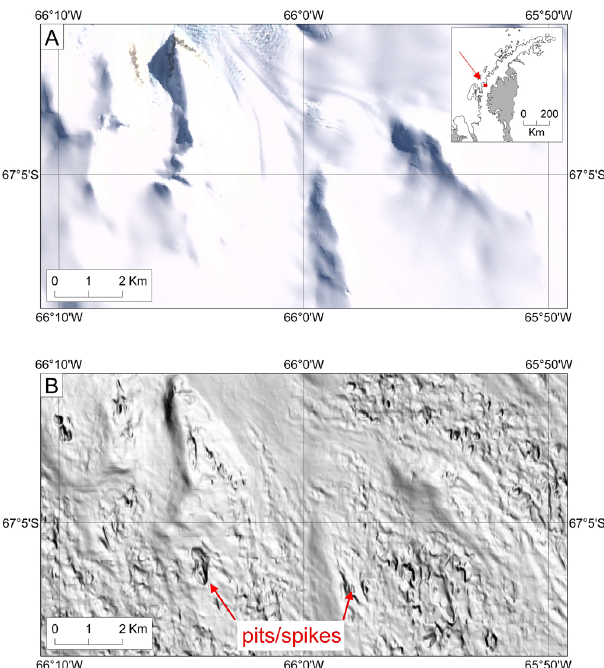
Figure 1. Sample area showing features visible on LIMA satel- lite image, displaying crevassed high-texture regions, rock out- crops and smooth surface low-relief slopes (A) . The raw ASTER GDEM has been hillshaded to show the problems in the dataset such as pits / spikes, which primarily occur on the featureless surface slopes (B)